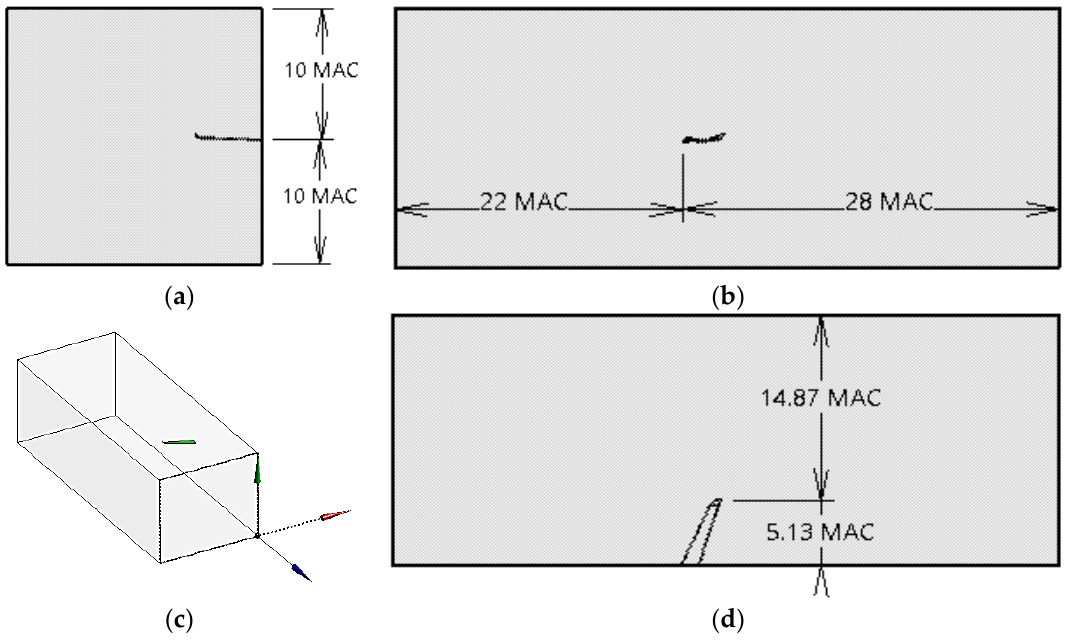
Figure 6. Computational domain: ( a ) front view, ( b ) left side view, ( c ) perspective view, and ( d ) top view.